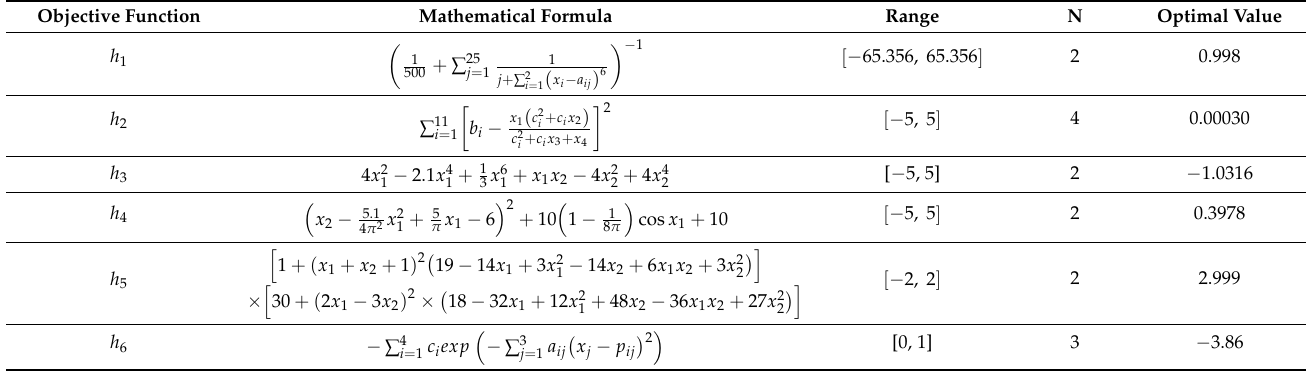
Table 4. Fixed-Dimensional Multimodal Objective Functions (Objective Functions h 1 − h 10